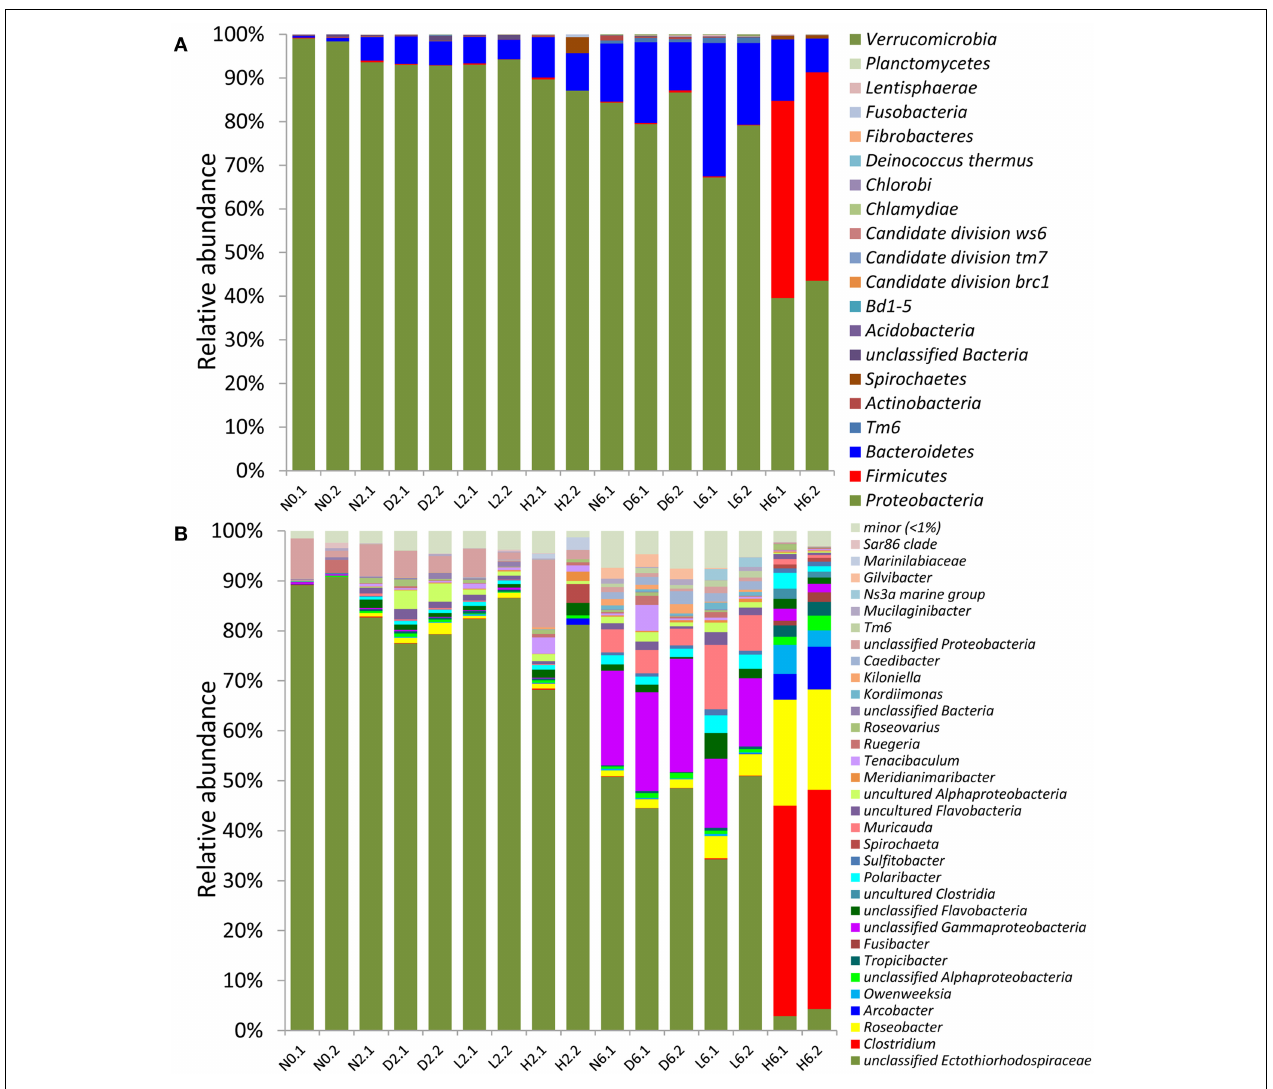
FIGURE 2 | Taxonomic composition of the bacterial communities in the treated sponge samples and controls (with read numbers > 1000). Classification of the pyrosequenced reads was performed using the RDP